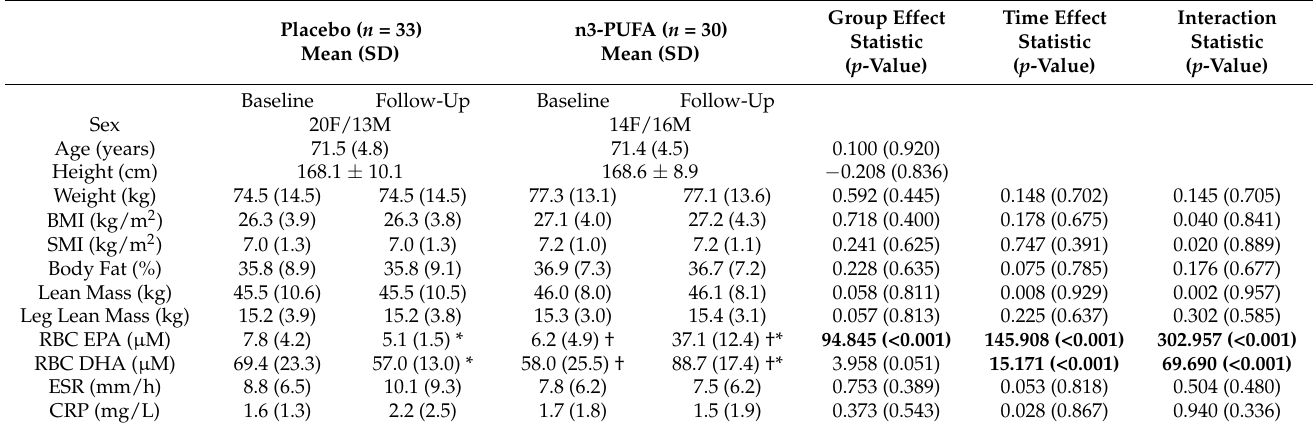
Table 1. Participant characteristics and body composition before and after 6 months of placebo or n3-PUFA